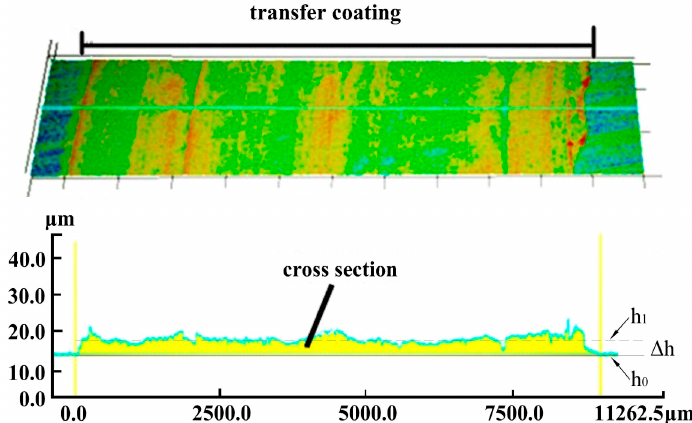
Figure 2. Measuring principle of the transfer layer thickness.